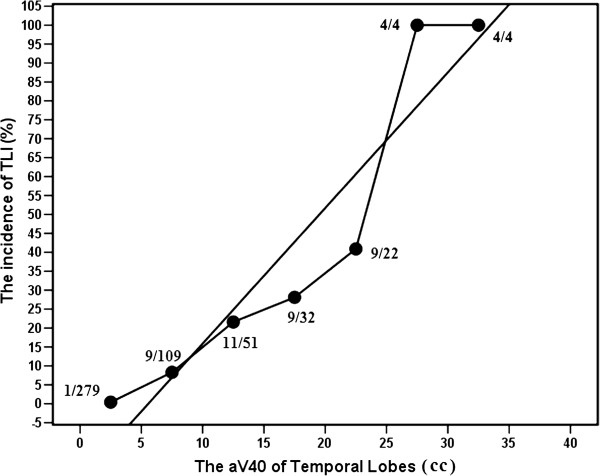
Plot of 5-year incidence as function of aV40 for temporal lobes.